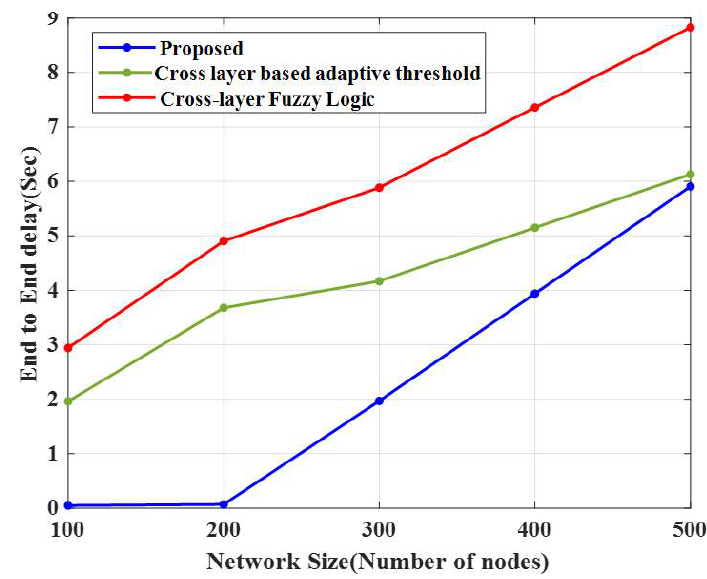
Figure 8. Performance of end-to-end delay.